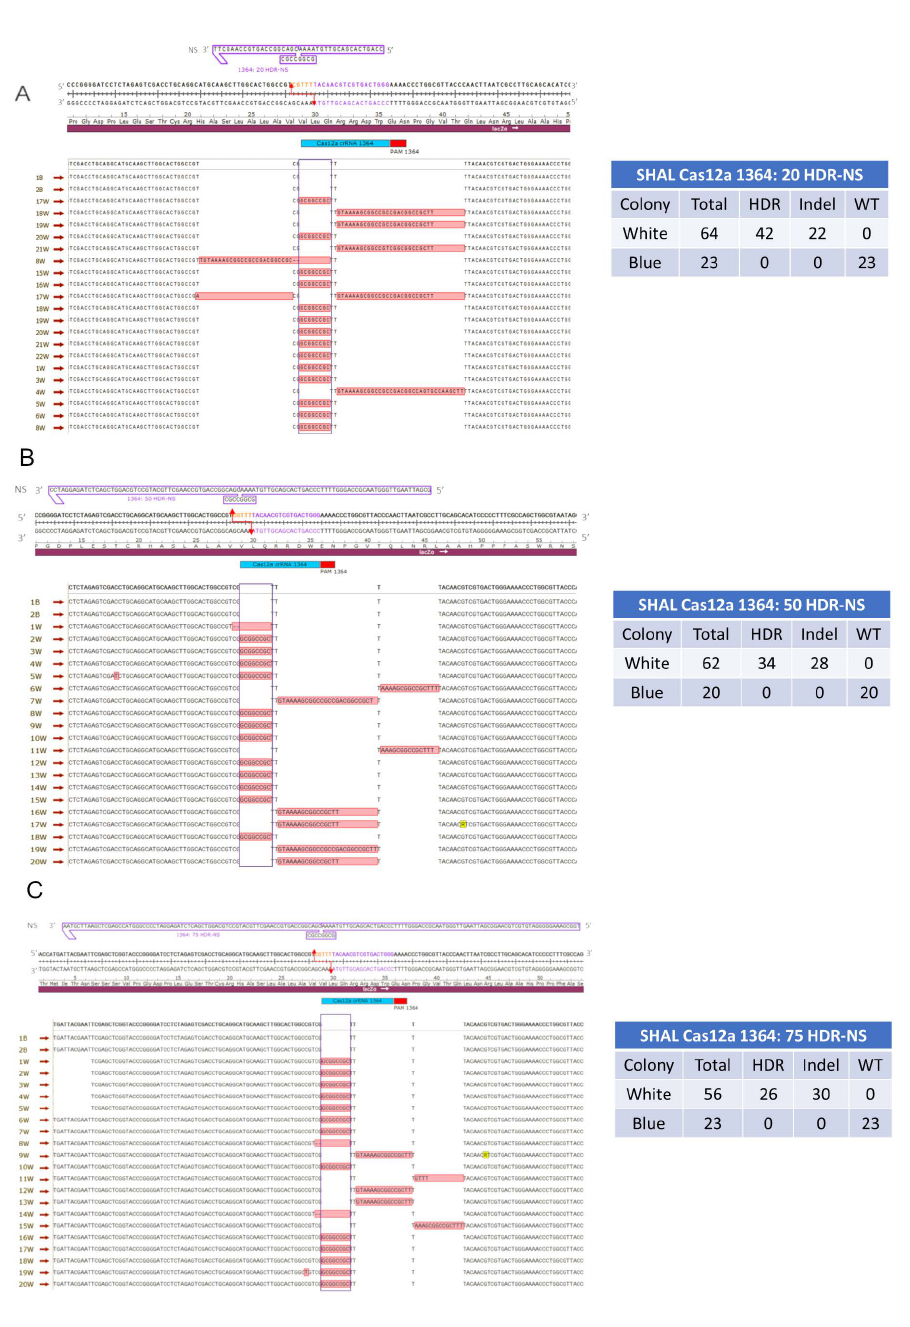
Figure 3. ( A – C ) Symmetrical homology arm lengths using CRISPR / Cas12a. Each image illustrates Cas12a in blue with the PAM site in red and a staggered red arrow indicating the five base, 5 (cid:48) overhang created after cleavage occurs. ( A – C ) Symmetrical homology arm lengths of 20, 50, and 75 base pairs (48, 108, and 158 bases total). The nonsense symmetrical oligonucleotide with lengths of 20, 50, or 75 base pairs on either side of the cut site is located above the lacZ gene, contains an eight base NOTI site in the center, and is positioned in a 3 (cid:48) –5 (cid:48) orientation. The purple box highlights the correct integration of a NOTI site while bases highlighted in red outside of the purple box, indicate unintended integration or deletion events. The table to the right of the images illustrates the total number of blue and white colonies sequenced and if they were found to harbor homology-directed repair, insertions or deletions (Indels), or a wild-type event. All blue colonies were found to harbor wild-type sequences represented by the two blue colonies (labeled 1B and 2B) in all images. All experiments were conducted in triplicate and the combined data is shown only in the tables present. The remaining sequencing data is shown in Figure S1 and the individual colony numbers for each trial are shown in Table